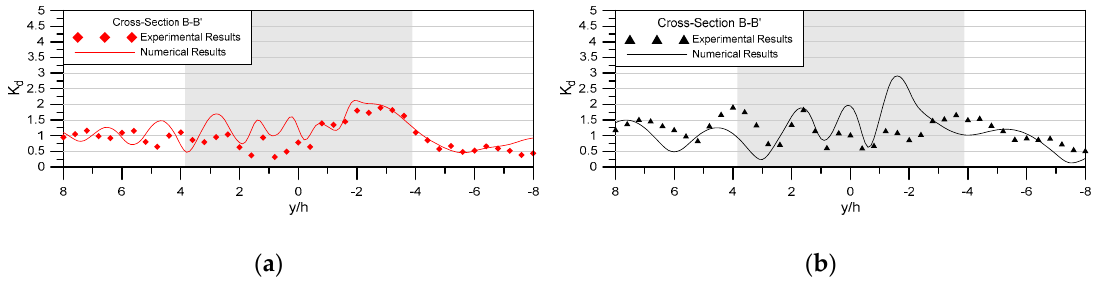
Figure 10. Comparison of the experimental and numerical wave-height ratios K d at the cross-section B–B (cid:48) for wave conditions of ( a ) σ 2 h / g = 2.012 and ( b ) σ 2 h / g = 0.894 at oblique incidence ( α = 120 ◦ ) . The shaded area indicates where the plate starts and ends for the given cross-section.